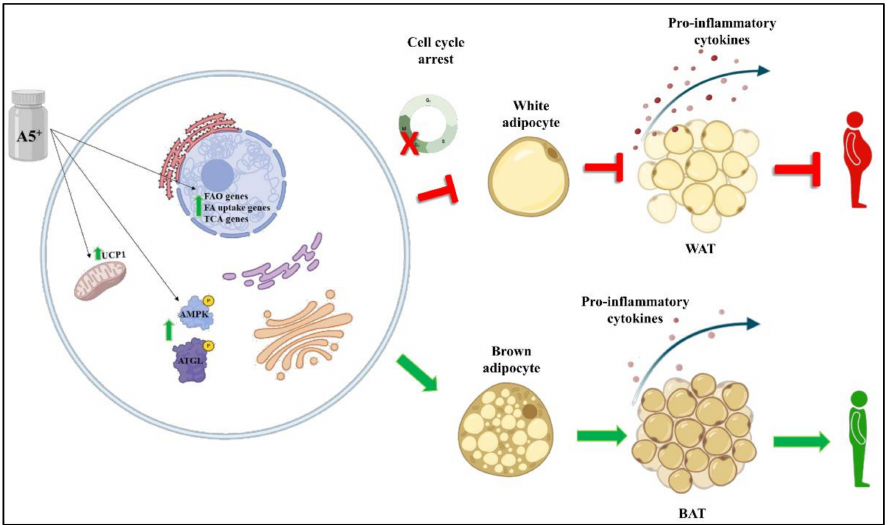
Figure 7. Schematic representation of A5 + effects on adipogenesis and browning. A5 + administration increased the expression levels of several genes involved in FAO, FA uptake and TCA. Moreover, it also promoted the activation of the AMPK-ATGL pathway and increased the expression levels of UCP1, leading to BAT generation and reducing the pro-inflammatory state typical of obesity and white adipogenesis. Created by